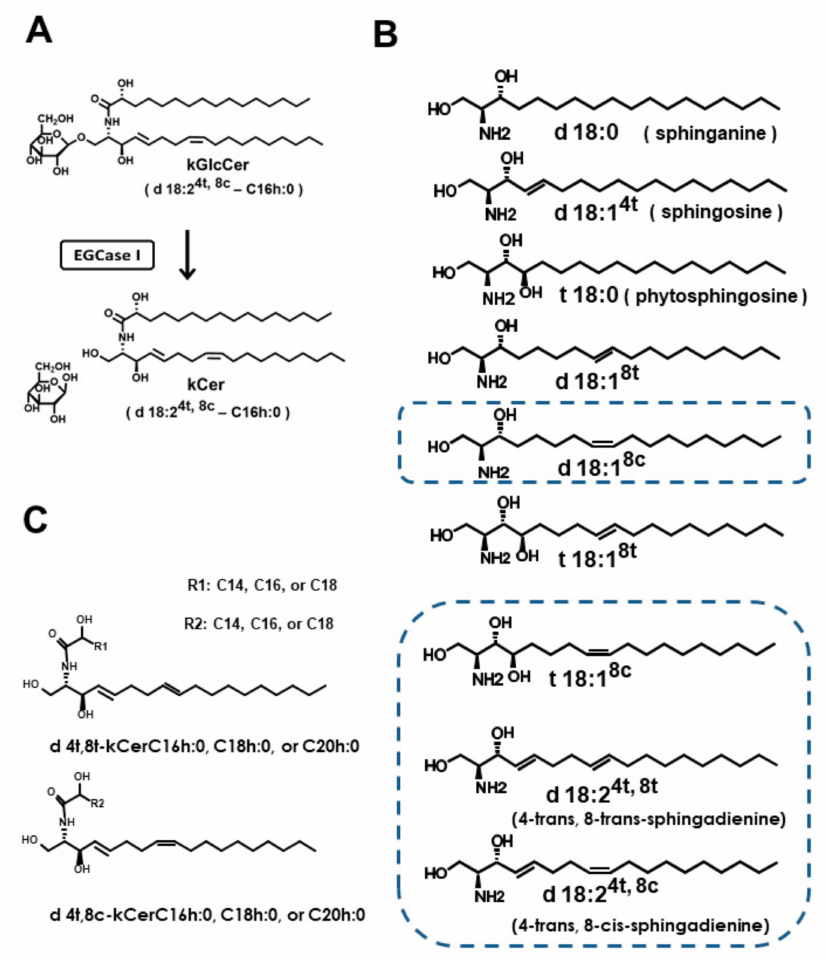
Figure 1. The nomenclature of long-chain bases and ceramides following the recommendations of the IUPAC-IUBMB Joint Commission. ( A ) The endoglycoceramidase (EGCase) reaction of konjac glucosylceramide (kGlcCer). Plant-type ceramides can be prepared from plant-type glucosylceramide (GlcCer) by EGCase I treatment. a major molecular species (d18:2 4t, 8c -C16h:0) of konjac ceramide (kCer) is shown. ( B ) The main long-chain bases found in plants. The long-chain bases of kCer produced by EGCase treatment are delineated by a dotted line rectangle. ( C ) kCer molecular species generated by EGCase treatment of kGlcCer. The length of the carbon chain of each hydroxyl fatty acid (C16 to C20) is